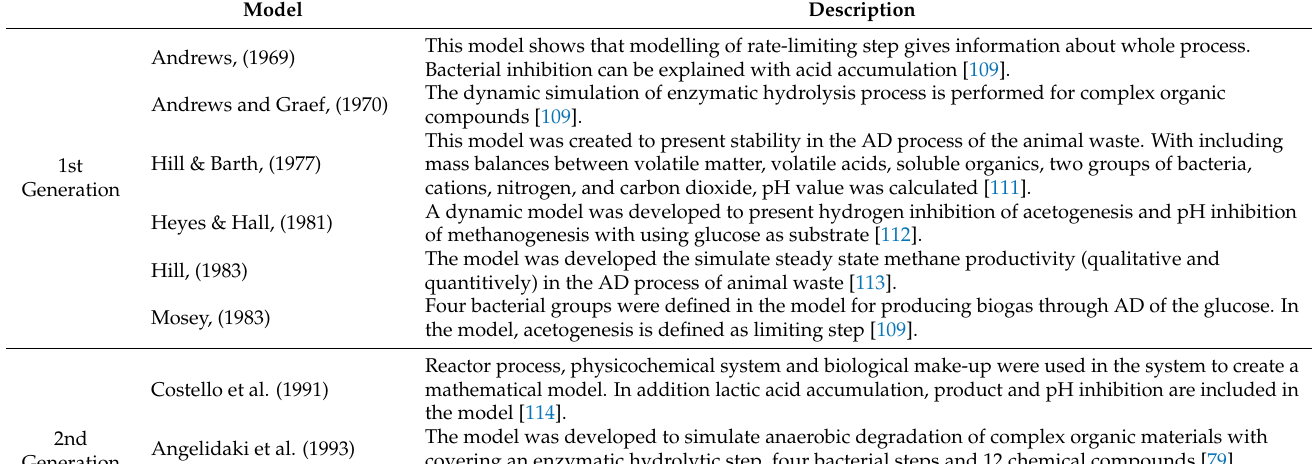
Table 2. Created models for biogas